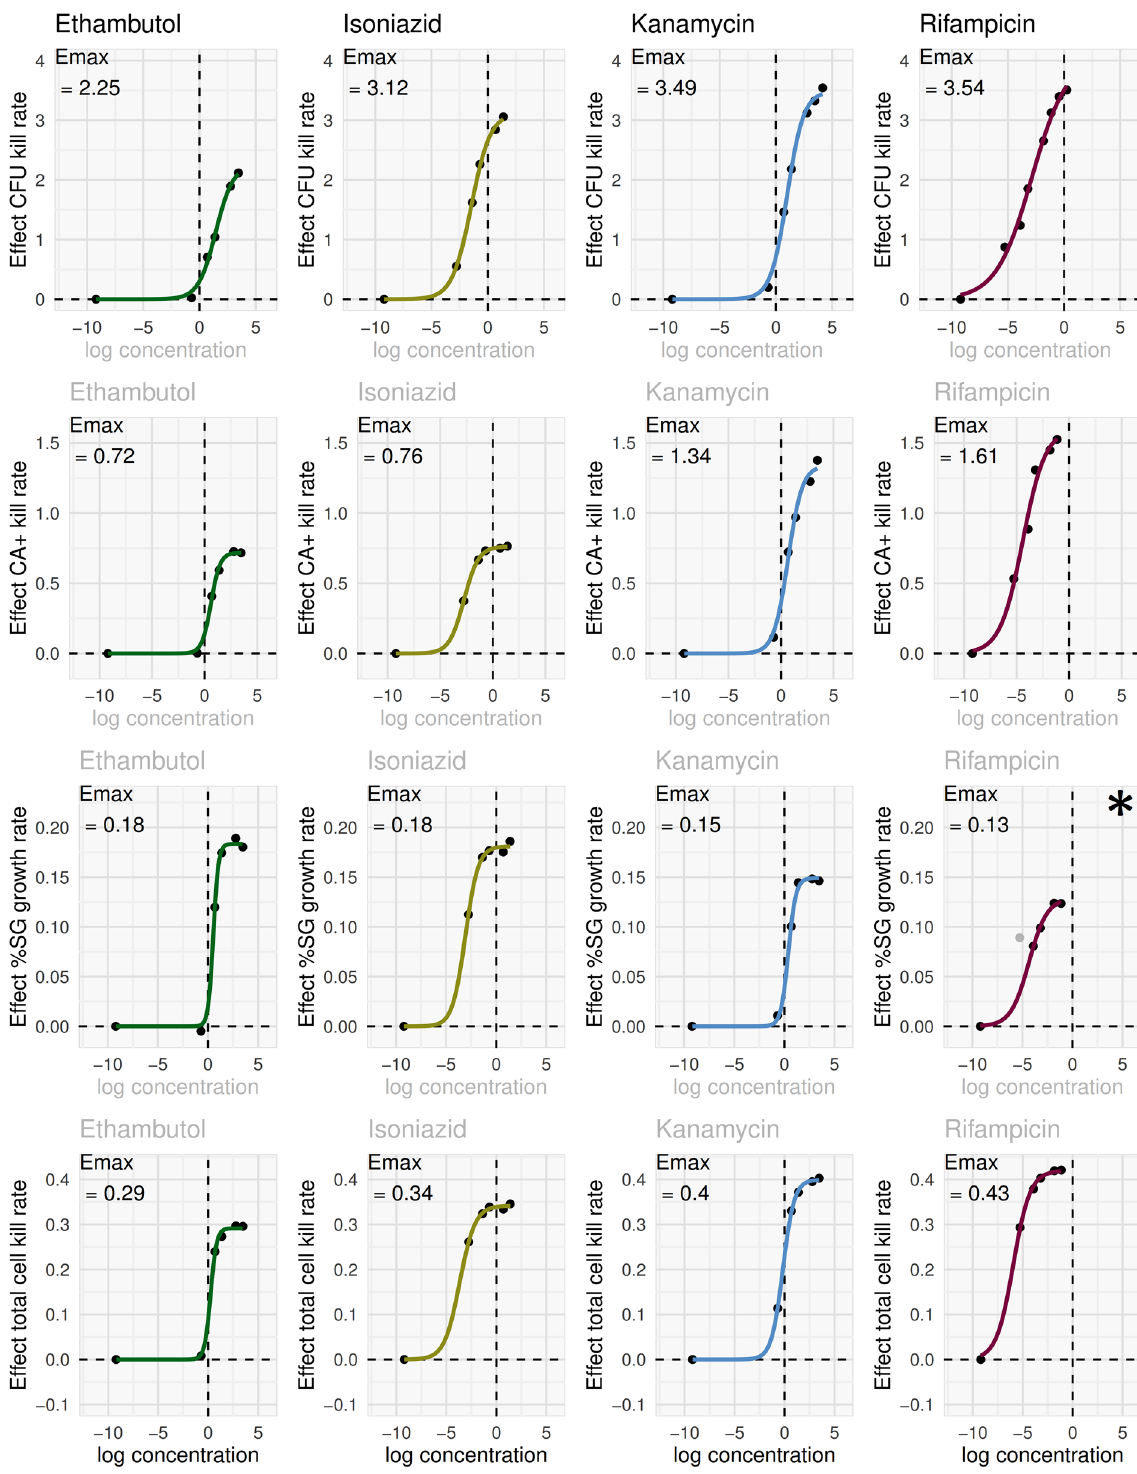
Figure 10. E max models applied to time-kill data from FCM defined cell population and CFU counts. The time-kill data in Fig. 9 were modelled using a linear mixed-effects model to extract an estimate of mono- exponential elimination rate for each antimicrobial condition as a summary pharmacodynamic (PD) measure for each FCM defined cell population and CFU counts. Antimicrobial effects extracted from these models were related to drug concentration for each antimicrobial using a standard sigmoid E max PK/PD model, shown here for each antimicrobial (columns) and each cell population (rows). *A sigmoidal E max model could not be fit for rifampicin %SG + growth rate data due to non-convergence; the fit shown is from a model excluding the outlier data point at concentration 0.005 mg/ml (− 5.3 on log scale). When this data point (indicated in grey) was excluded, the model